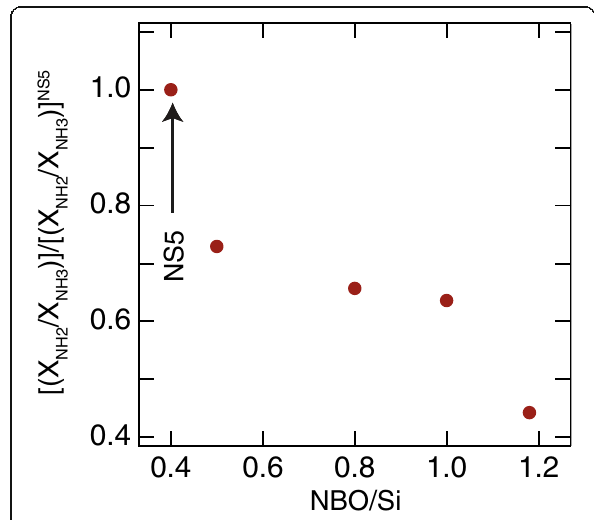
Fig. 21 Evolution of NH 2 /NH 3 abundance ratio in melts as a function of degree of silicate polymerization, NBO/Si (data from Mysen and Fogel